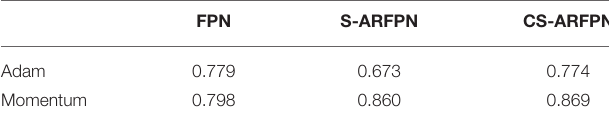
TABLE 5 | Performance comparison of models using Adam and Momentum. FPN S-ARFPN CS-ARFPN